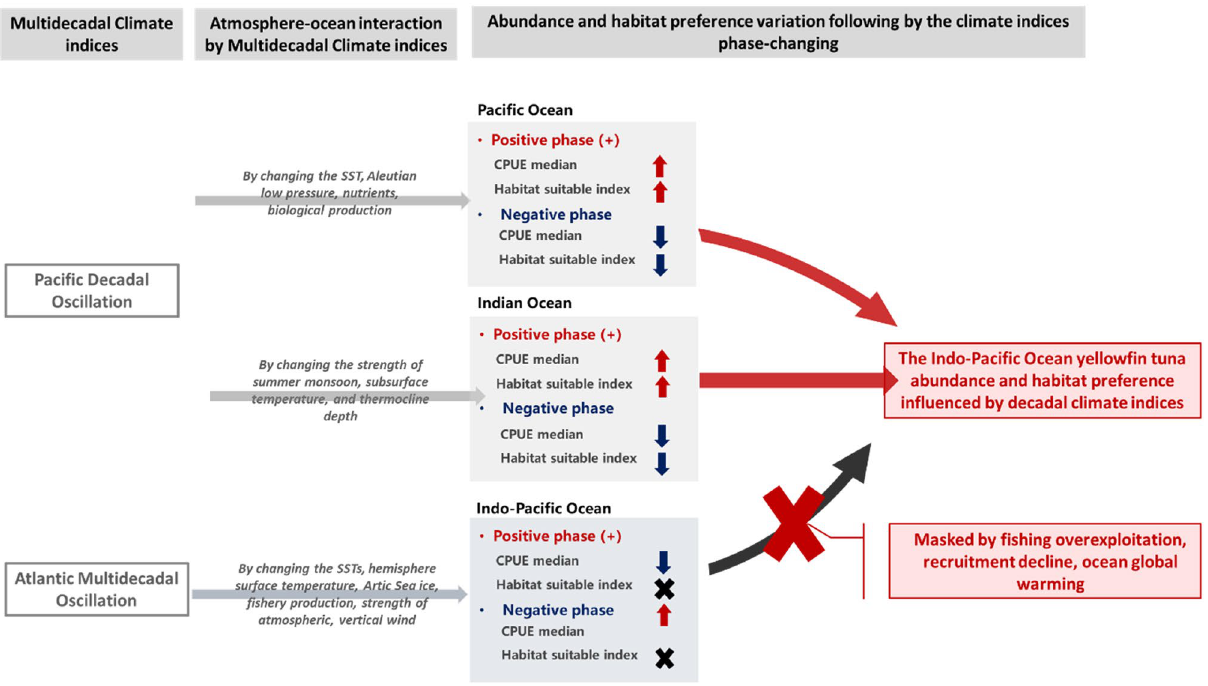
Figure 6. Mechanism by which multidecadal climate variability affects Indo-Pacific Ocean yellowfin tuna abundance and habitat